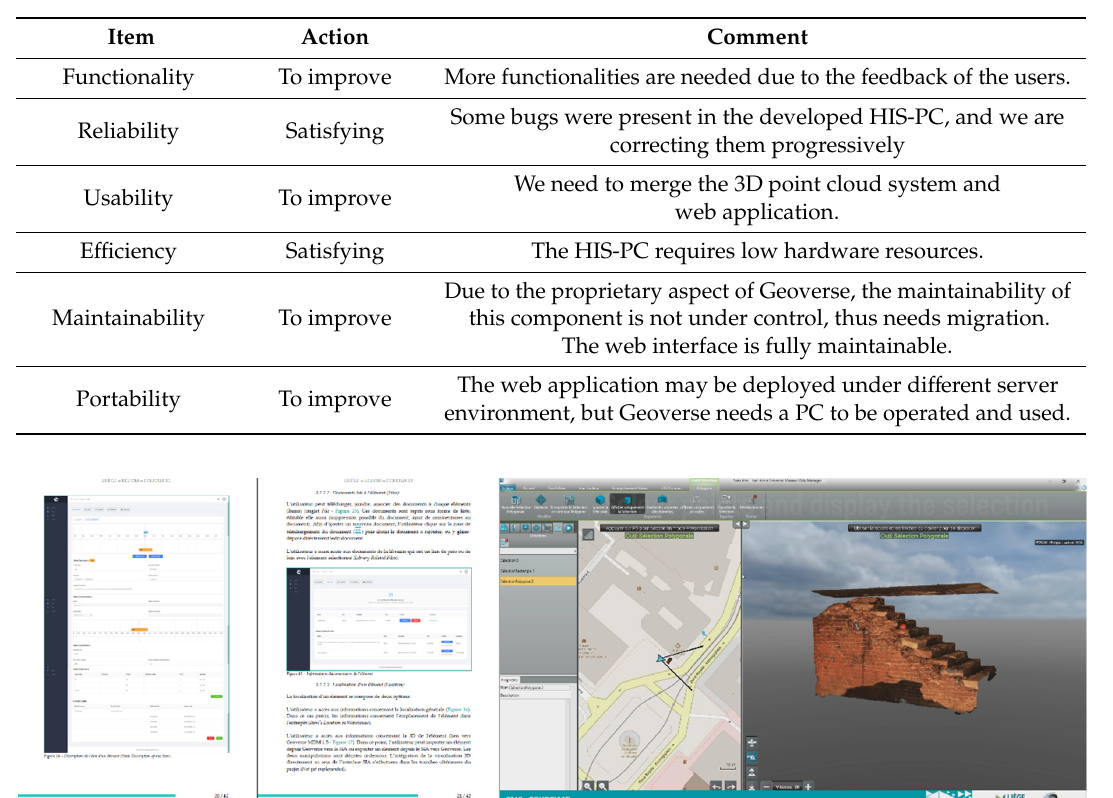
Figure 24. Extract of the user manual and video tutorial for the end users.